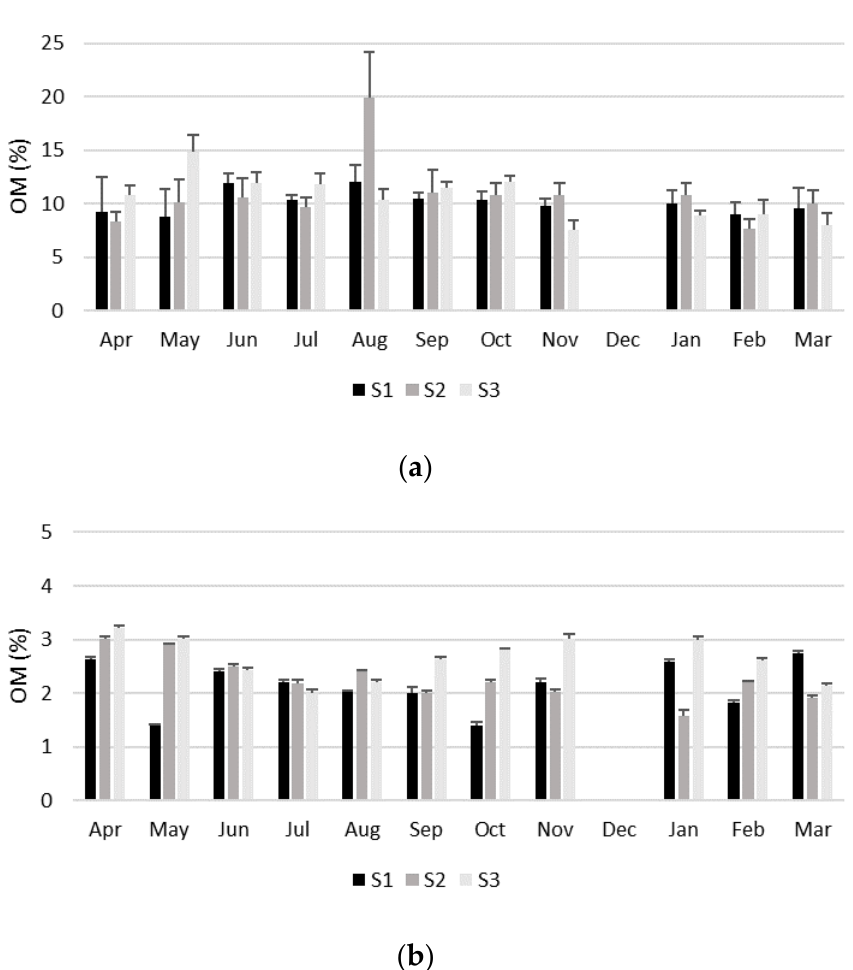
Figure 4. Organic matter content (OM) in: ( a ) suspended matter and ( b ) sediment samples collected at stations S1 to S3 in the Kaštela Bay (Adriatic Sea, Croatia) from April 2015 to March 2016.